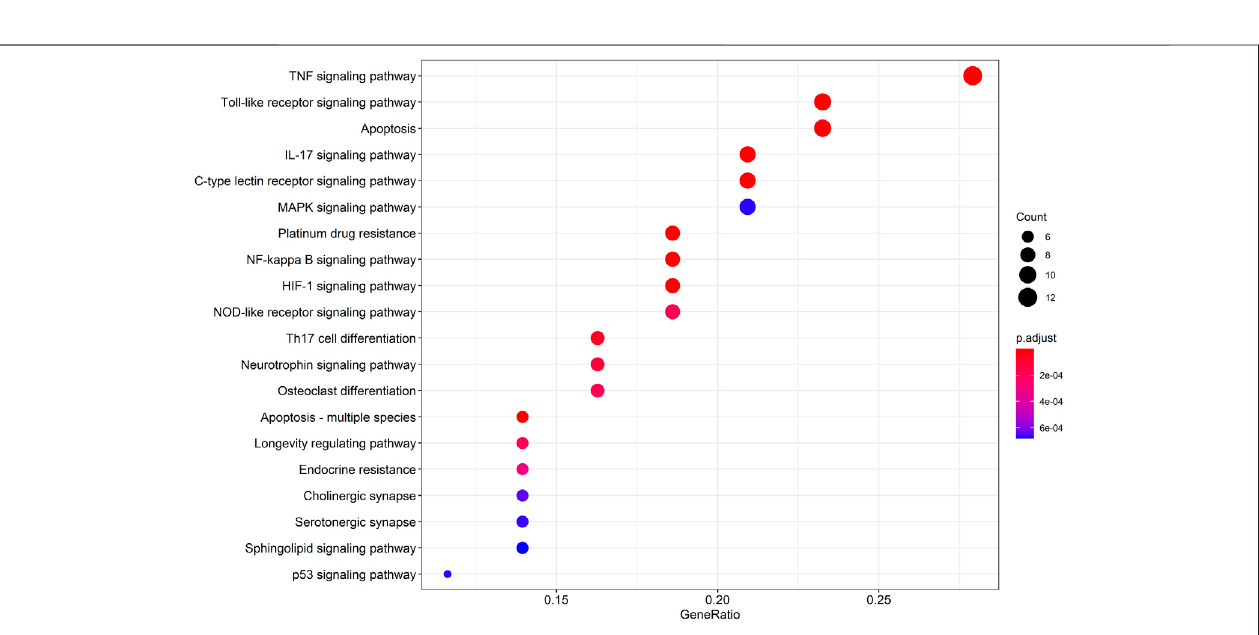
Frontiers in Pharmacology |